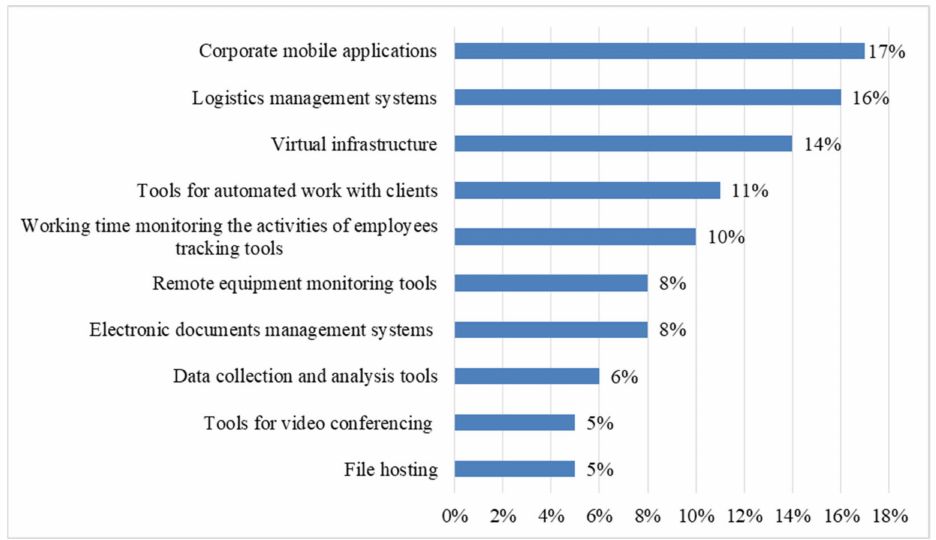
Figure 3. ICT—tools that will be in demand in the near future according to respondents from manufacturing enterprises of the Republic of